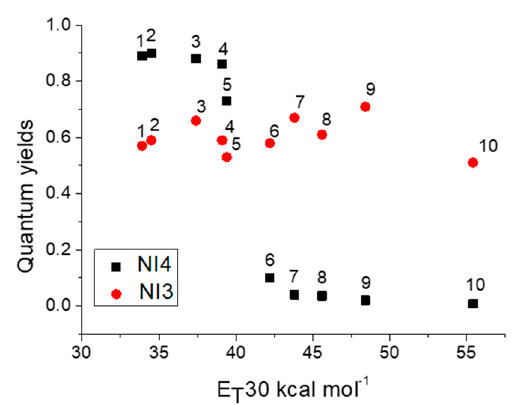
Figure 4. Dependence of quantum fluorescence yields of NI3 and NI4 on the empirical parameter of solvent polarity E T (30): 1-toluene, 2-diethyl ether, 3-tetrahydrofuran, 4-chloroform, 5-dichloromethane, 6-acetone, 7-DMF, 8-acetonitrile, 9-2-propanol-2, 10-methanol.